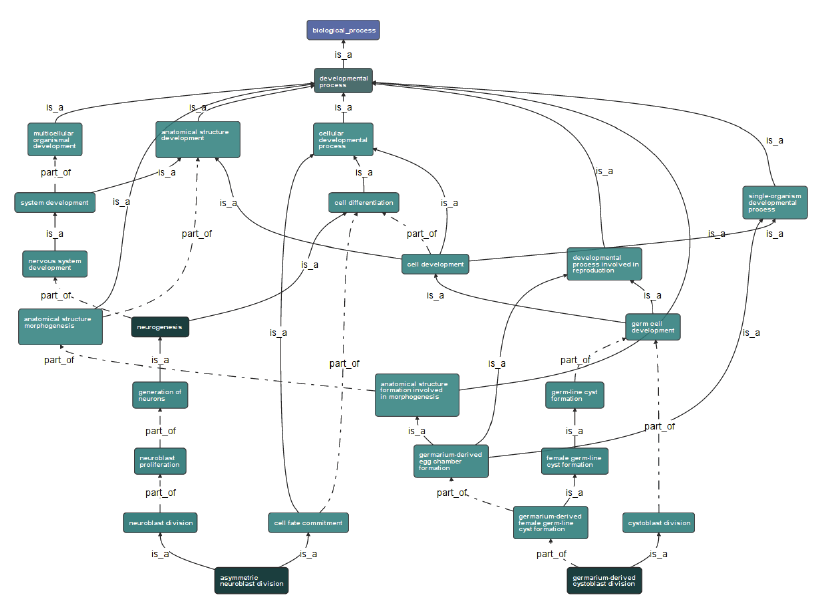
Figure 3. The graph viewer, displaying a subgraph of annotations from the Gene Ontology for the Drosophila melanogaster gene cdc2 , selected using the control